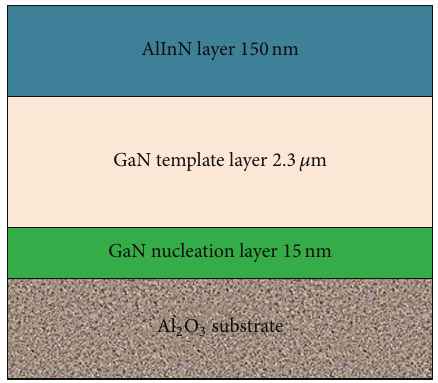
Figure 1: Schematic drawing of the AlInN/GaN/Al 2 O 3